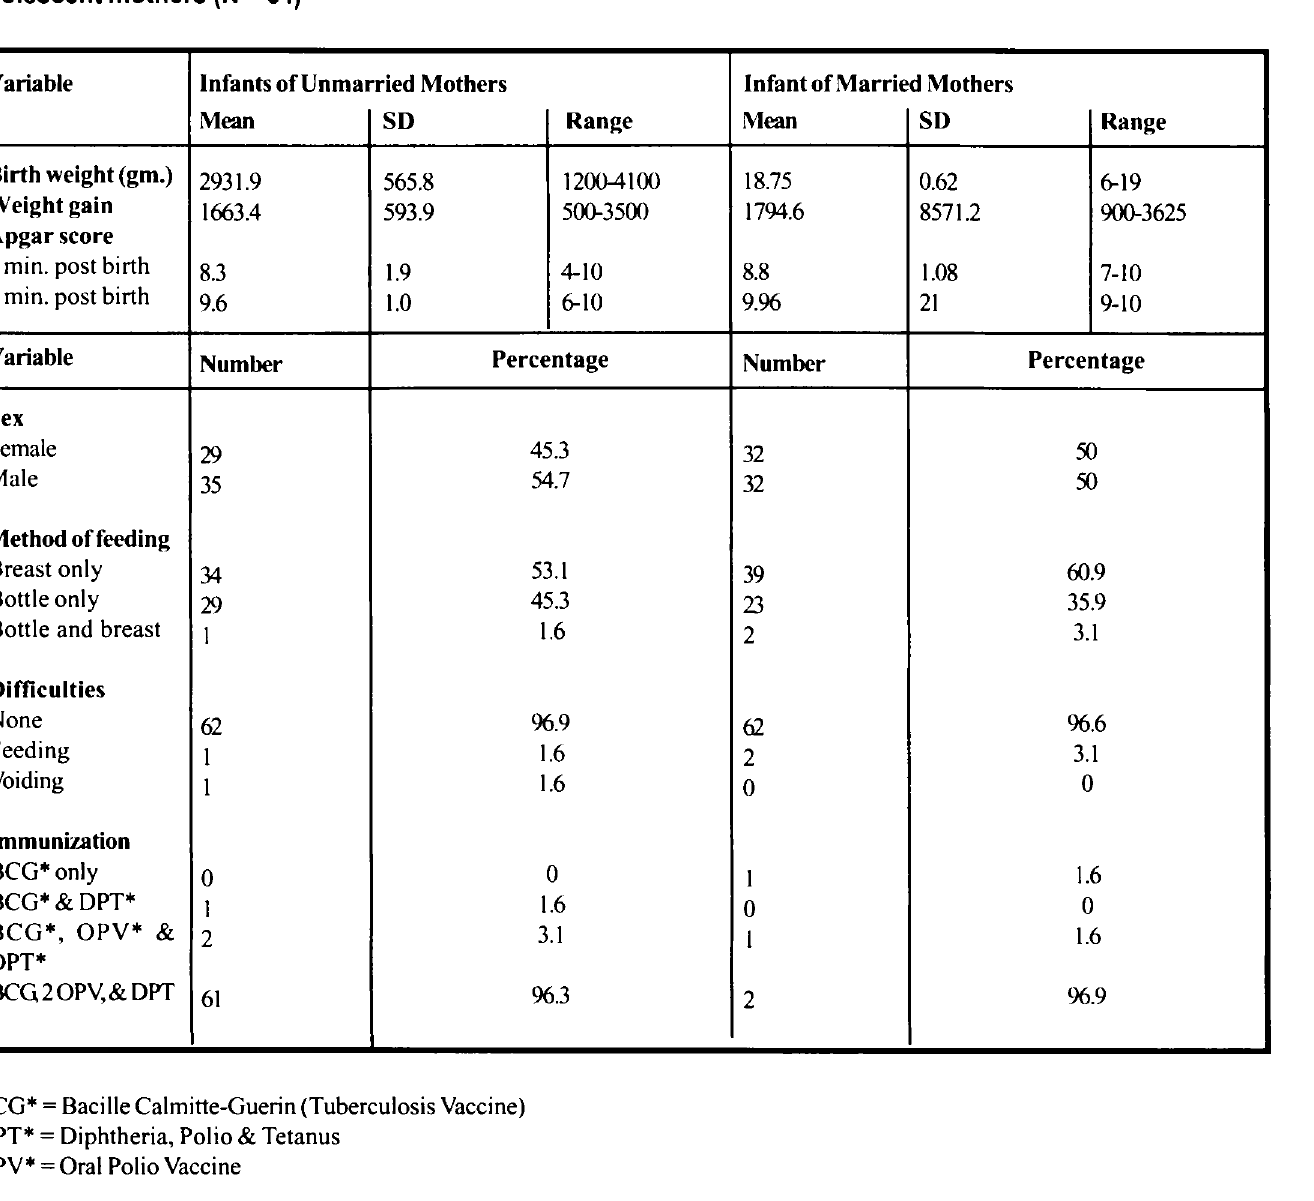
Table 3 Descriptive statistics: Infants of unmarried adolescent mothers (n = 64) and infants of married adolescent mothers (N = 64)